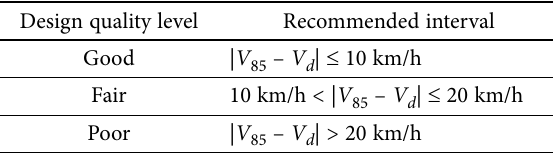
Table 2. Safety criterion I proposed by Lamm et al. (1999)